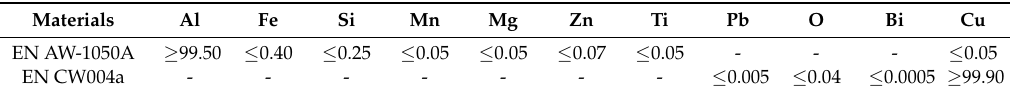
Table 1. Chemical compositions of the applied base materials